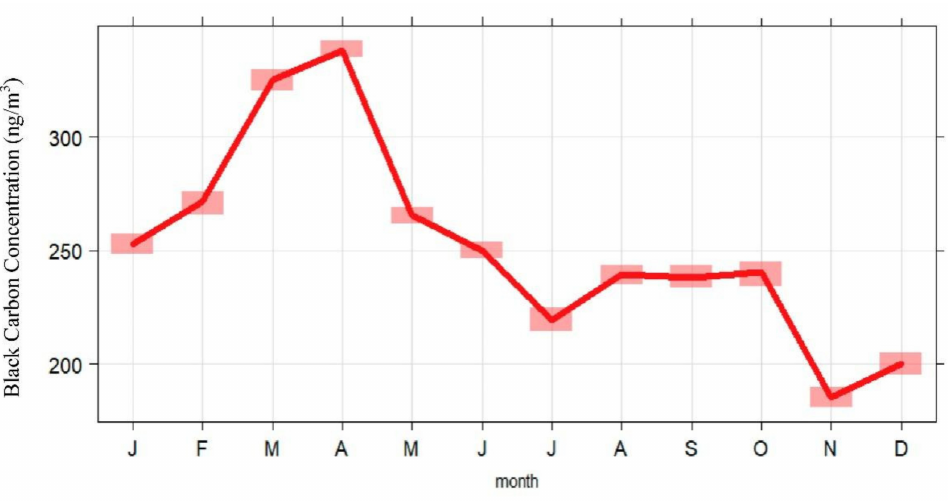
Figure 3. The 24-year monthly average concentration of black carbon aerosol at Mt.